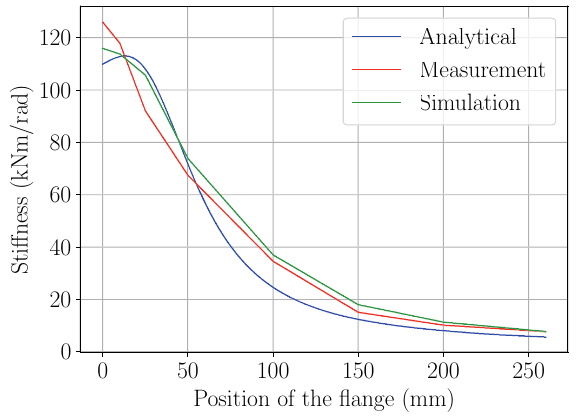
Fig. 5. Torsional stiffness curves from analytical calculations, FEM simulations and practical experiment. The stiffness values are plotted as a function of adjustable flange